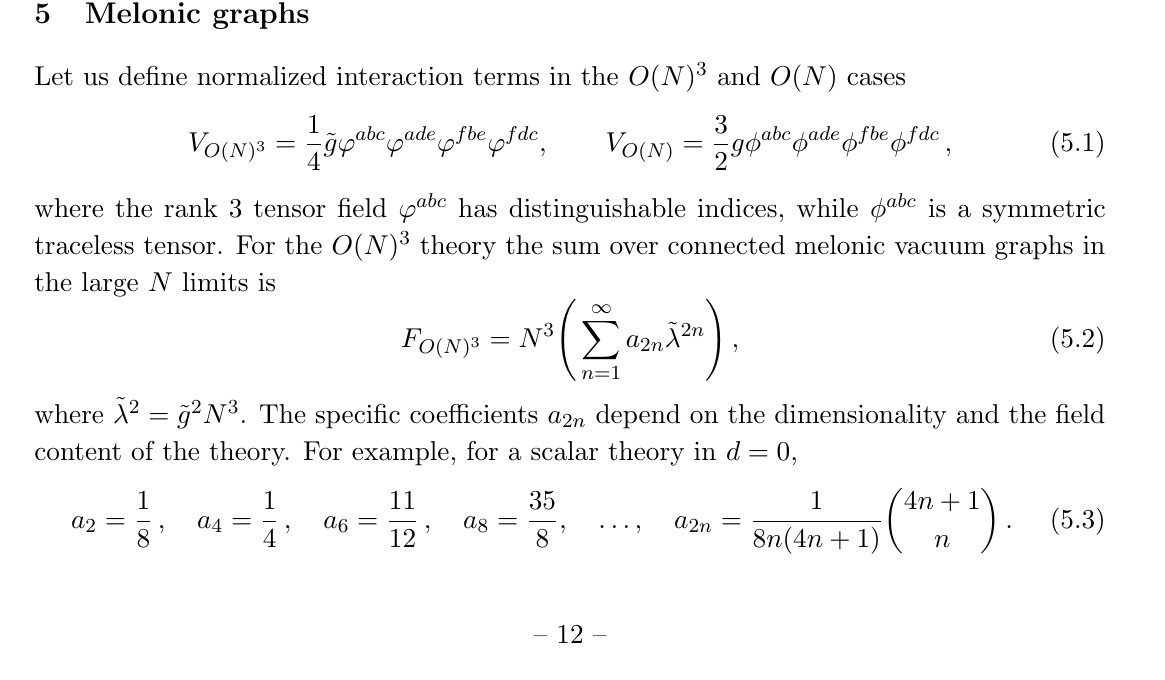
Figure 11 . Some non-melonic g 12 diagrams. They are all suppressed compared to the melonic ones which scale as N 21